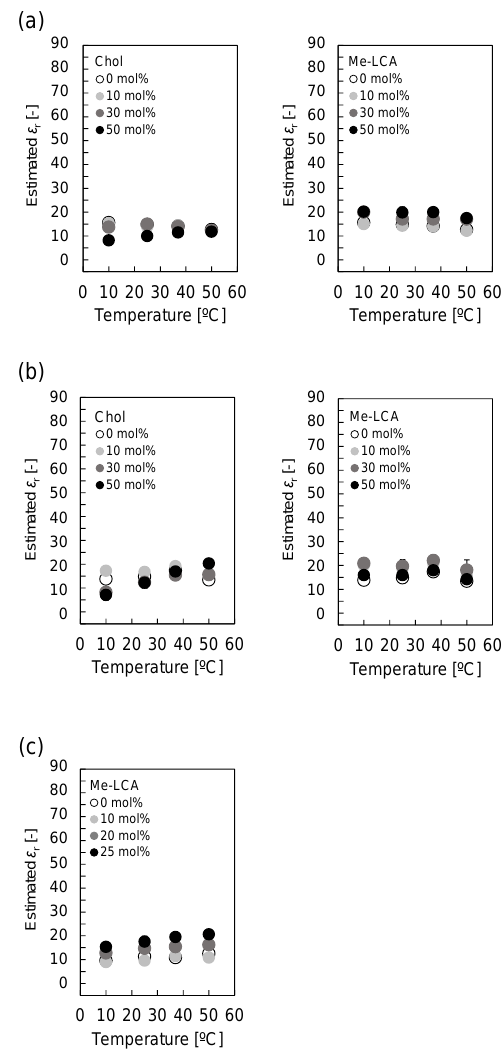
Figure 6. Estimated ε r values using Py-C 7 -COOH of ( a ) DOPC liposome, ( b ) DPPC liposome, and ( c ) DOPC/DPPC/Chol (1:1:1, mol/mol) liposome with Me-LCA.